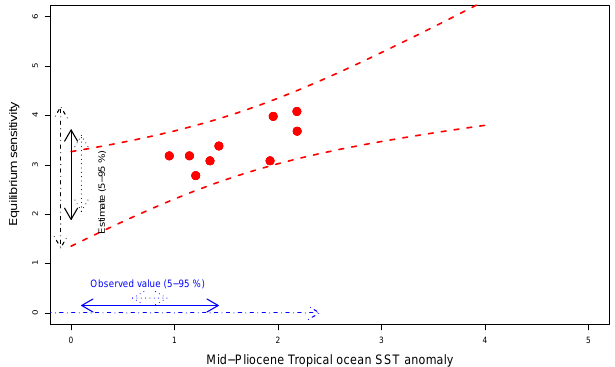
Figure 2. Estimating equilibrium climate sensitivity using the mPWP. Red dots represent model values; solid and dashed red lines indicate regression relationship and its uncertainty respectively. Blue arrows show proxy-based reconstruction of tropical temper- ature change over ocean, together with uncertainty of 0.1 (dashed), 0.4 (solid), and 1.0 (dot-dashed). Black arrows of the corresponding type show the resulting sensitivity